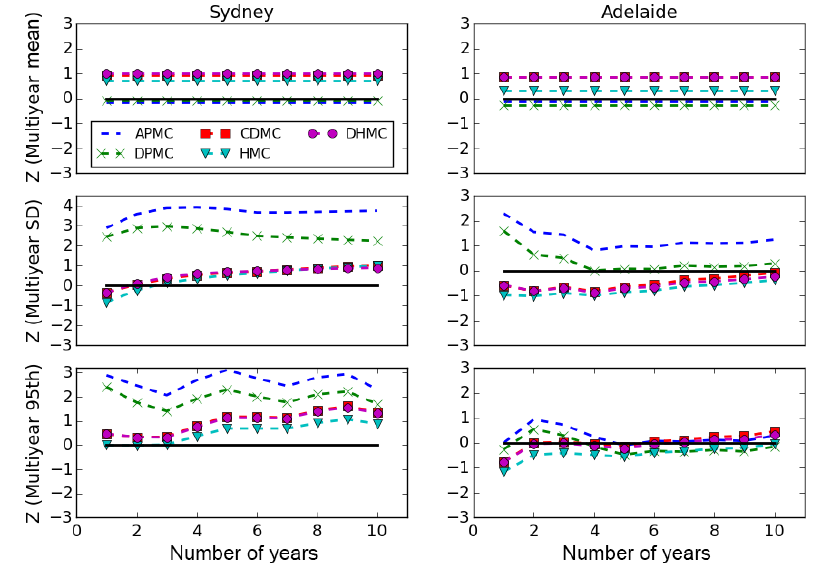
Figure 9. Comparison of the mean, SD, and 95th percentiles of multiyear rainfall depths for the five MC models.